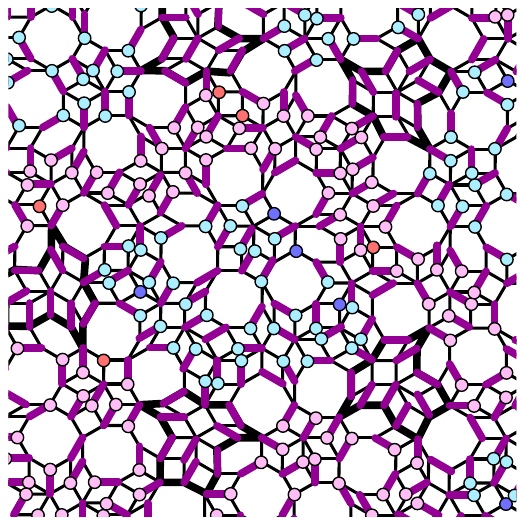
FIG. 18. A maximum matching of the Boyle-Steinhardt 12 B tiling [56]. Colors as in Fig. 17. Note the existence of perfectly matched regions within monomer membranes, thick black lines. These resemble manta rays converging on a coral reef at the center. These perfectly matched regions appear to be unique to the 12 B and 12 C